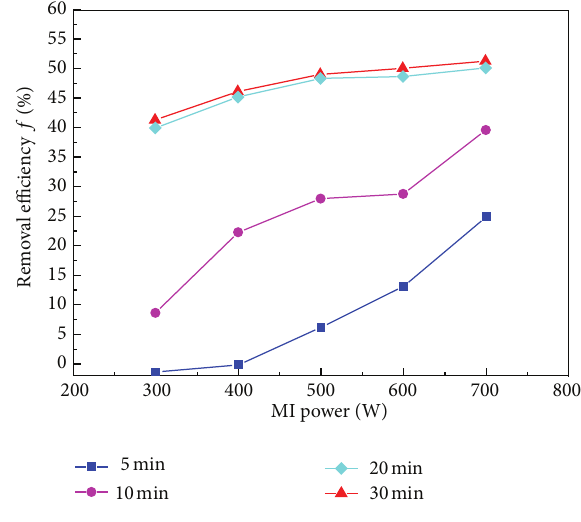
Figure 4: TC removal efficiency of different processes change over time.